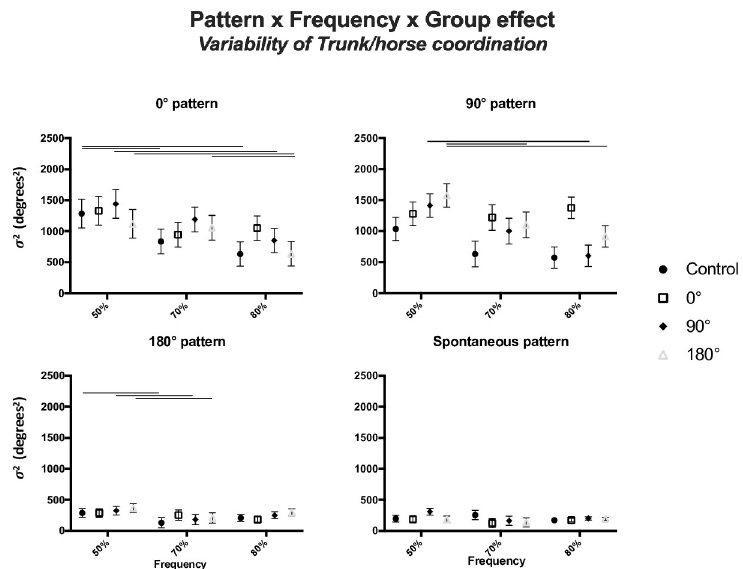
Fig 5. Depictions of the relative phase (left panel) and variability (right panel) of trunk/horse coordination (mean ± standard error) measured for all groups at each practice sessions (S1, S2 and S3). The horizontal lines characterize significant differences between